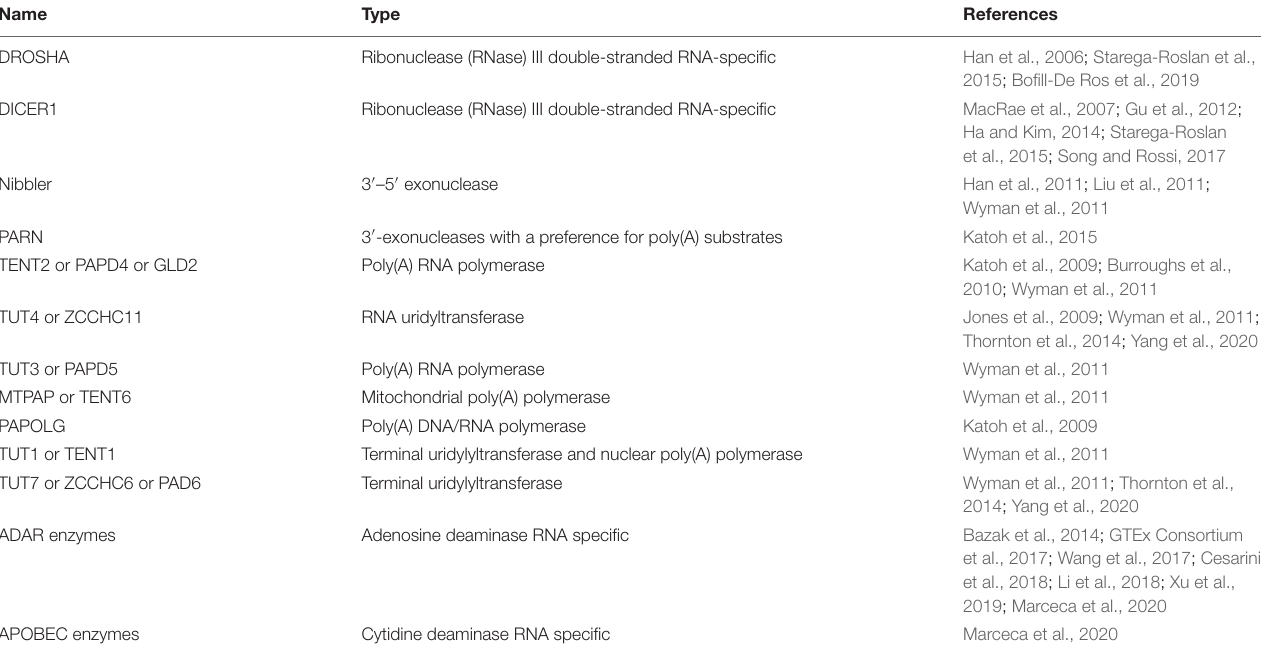
TABLE 1 | Enzymes affecting microRNA length and